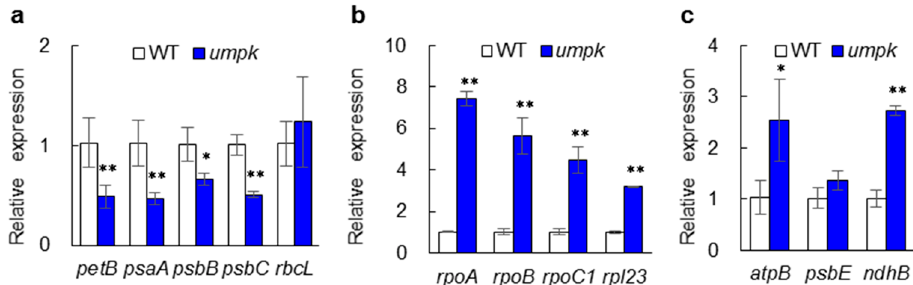
Figure 3. Expression of plastid genes in the WT and the umpk mutant. ( a ) Plastid-encoded RNA polymerase (PEP)-dependent genes. ( b ) Nucleus-encoded RNA polymerase (NEP)-dependent genes. ( c ) Both PEP- and NEP-dependent genes. Actin1 was used as an internal control. Data represent means ± sd ( n = 3). Significant differences are according to the Student’s t -test at * p < 0.05 and ** p < 0.01.